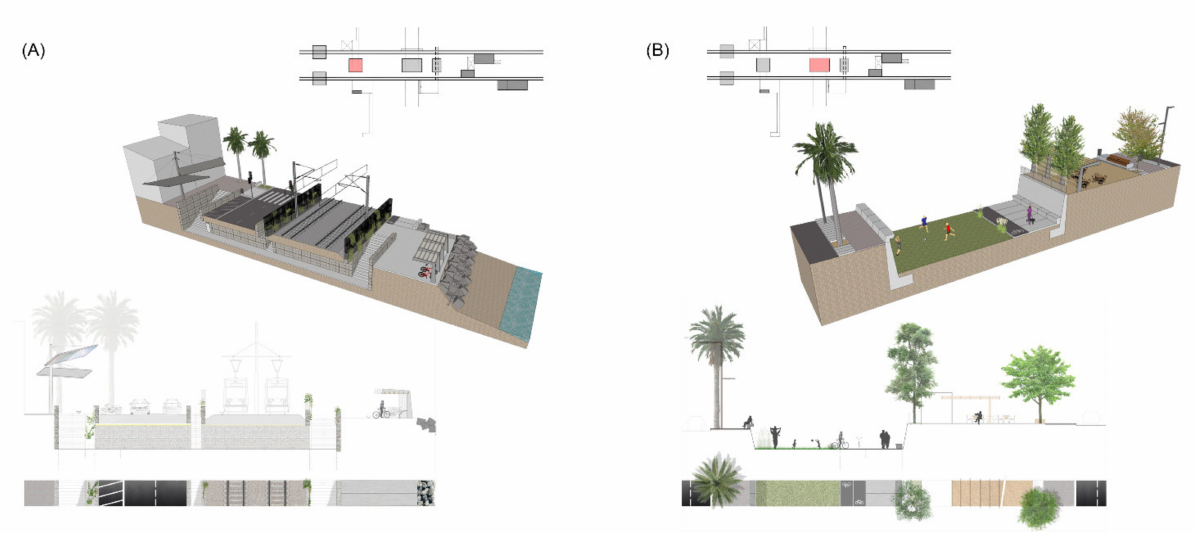
Figure 15. Standardized solutions for transversal typologies (Source: authors’ own). ( A ) Underground public space, non-floodable. ( B ) Underground public space,